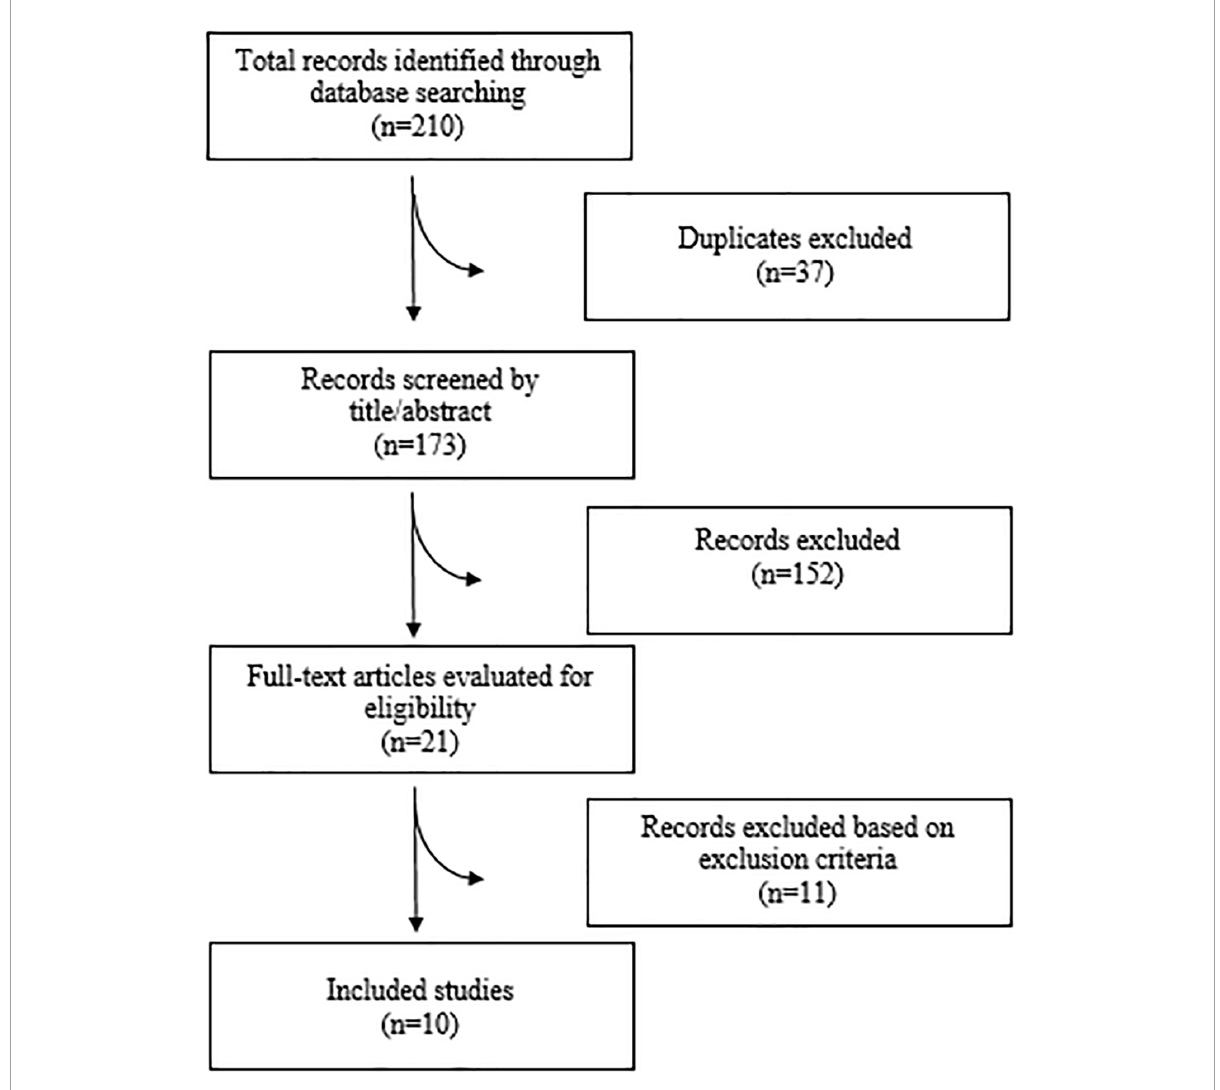
FIGURE1 Flow diagram of study